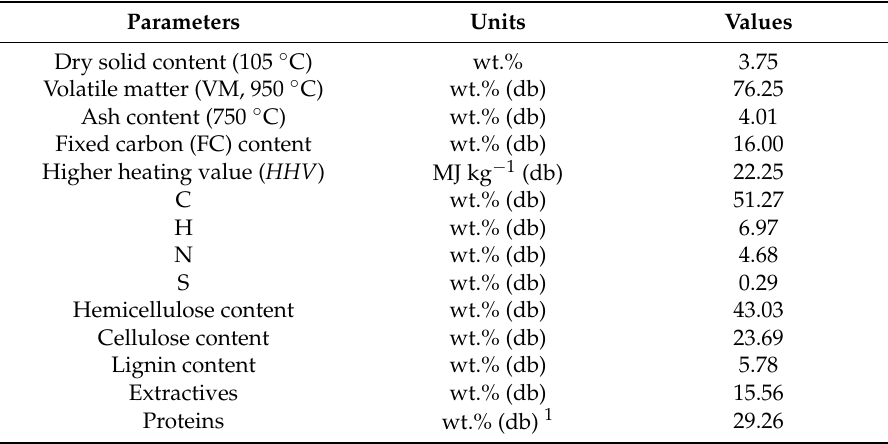
Table 1. Characterization of brewer’s spent grains (BSG). db: dry